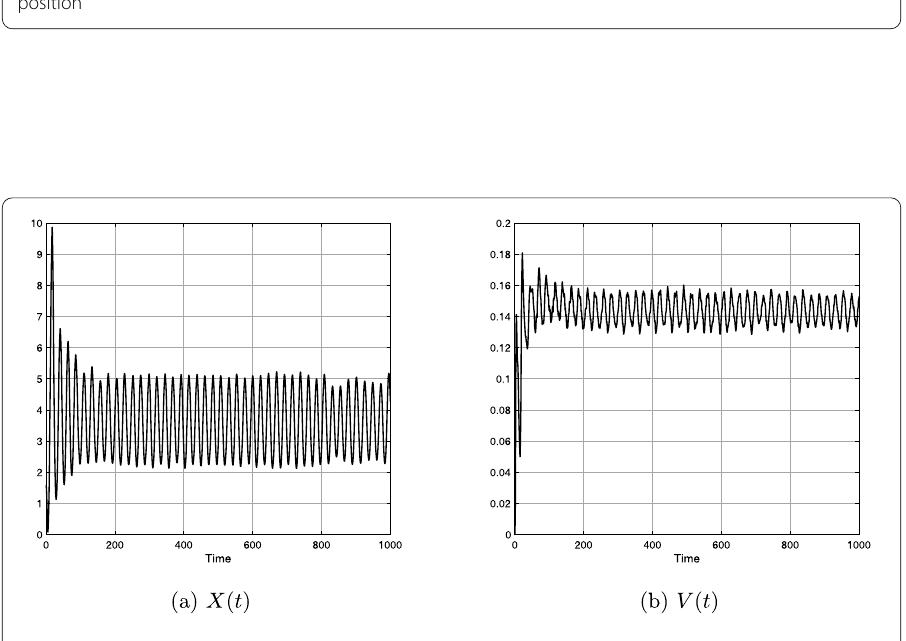
Figure 5 Dispersion and disagreement of Case I for t ∈